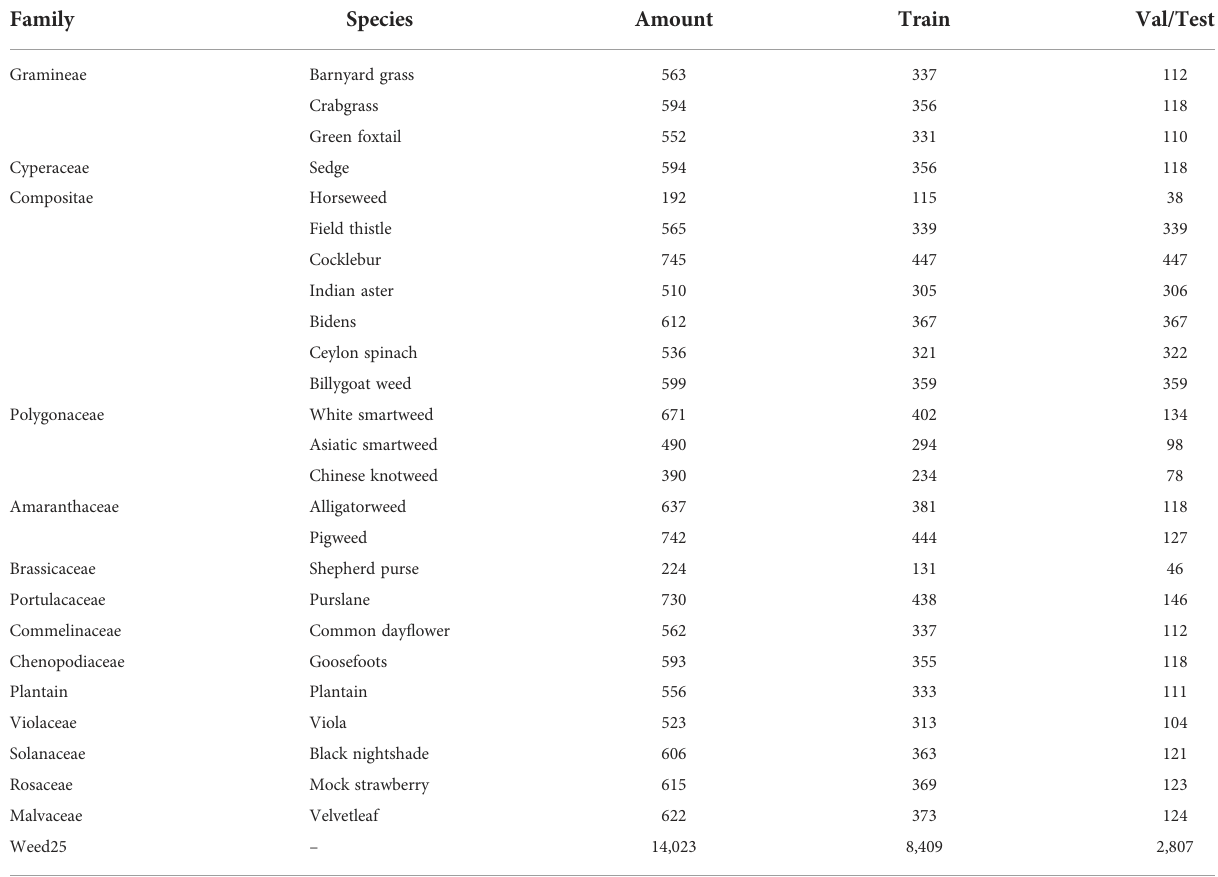
TABLE 2 Division of training/validation/testing (denoted as Train/Val/Test) datasets.